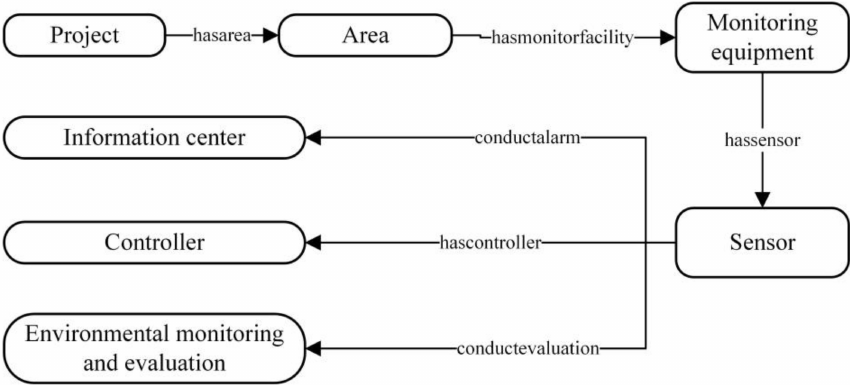
Figure 3. The relationship between the ontology objects of the E-CPS. After creating the above ontology, object attributes, and data attributes, the E-CPS ontologies can be constructed as Figure 4.